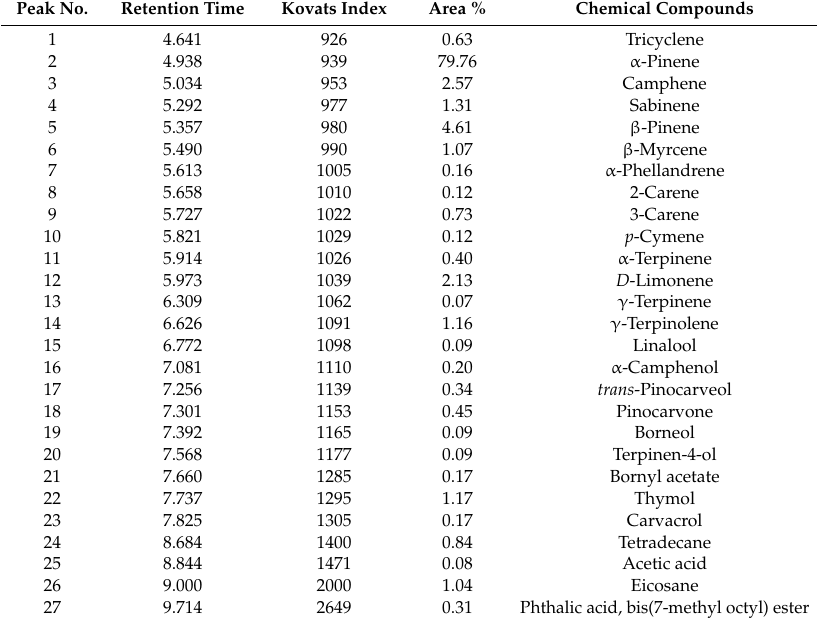
Table 1. GC Gas Chromatography-Mass Spectrometry (GC-MS) analysis of essential oil of Pistacia atlantica kurdica.